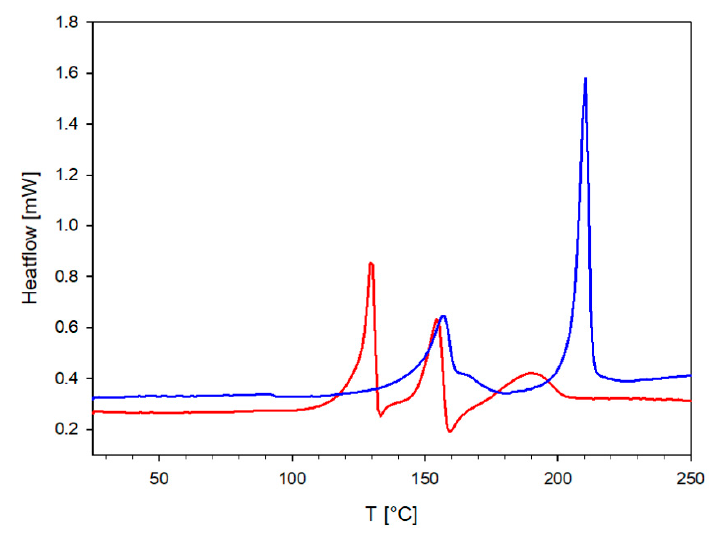
Figure 10. DSC curves of TrCOTyr · QX (red) and (TrCOTyr) 2 · QX (blue).